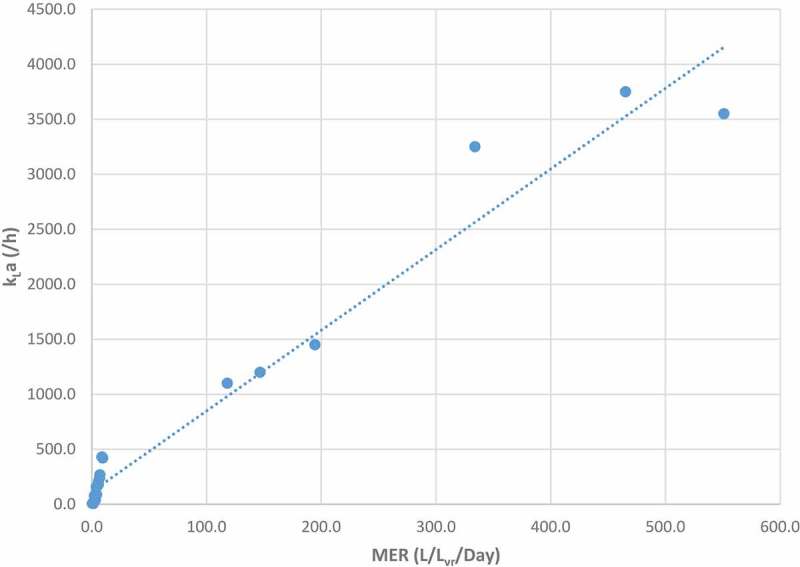
Comparison of MER vs kLa data in literature.